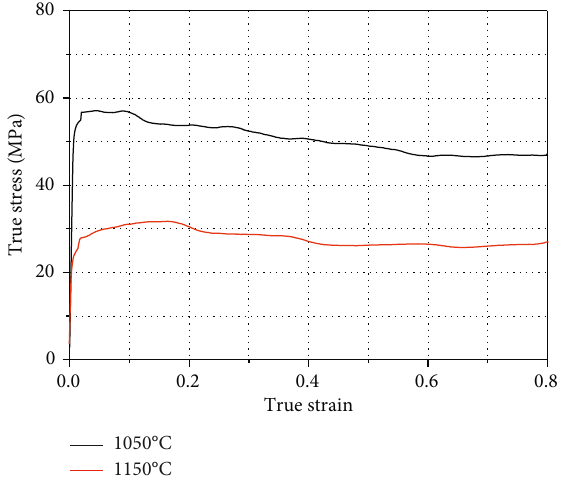
Figure 11: Flow curves of 18Mn18Cr0.6N steel deformed at 10 − 4 · s − 1